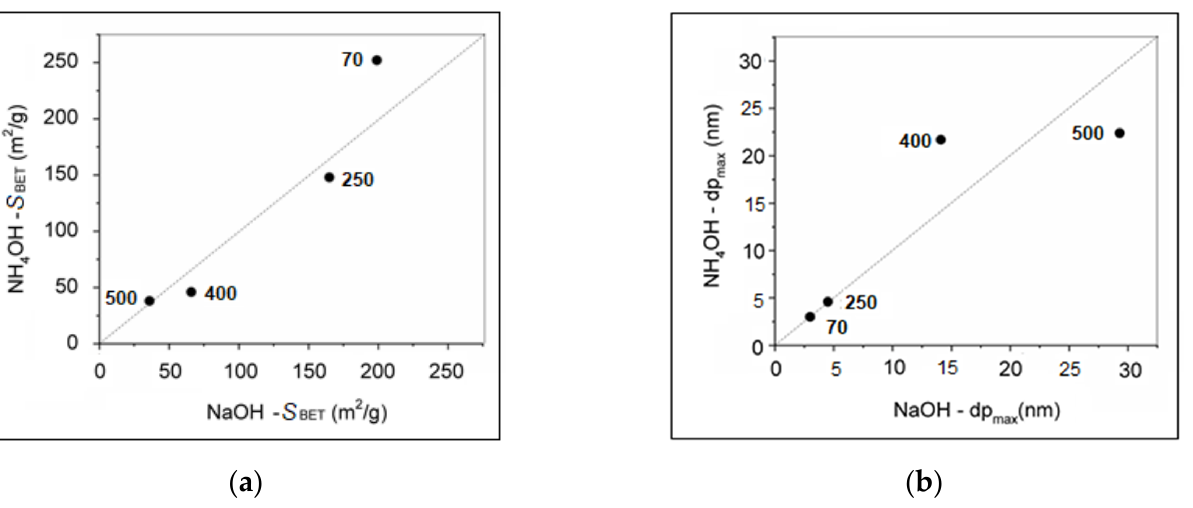
( b ) Figure 12. Hydrohematite samples after 2 h of the methane catalytic oxidation test: ( a ) XRD patterns with the peaks denoted as: H = Fe 2 O 3 and M = Fe 3 O 4 ; ( b ) The lattice parameters a, c of Fe 2 O 3 _Na ‐ 500 and Fe 2 O 3 _NH ‐ 500 catalysts were expanded in Fe 2 O 3 _Na ‐ 500 cat and Fe 2 O 3 _NH ‐ 500 cat . After the catalytic test, goethite in Fe 2 O 3 _Na ‐ 70 and protohematite in Fe 2 O 3 _NH ‐ 70 were reduced by CH 4 in Fe 2 O 3 _Na ‐ 70 cat and Fe 2 O 3 _NH ‐ 70 cat (Figure 12a) to the magnetite (PDF No. 01 ‐ 080 ‐ 7683) according to (Equation (5)). After 2 h of catalytic experiment, the highest CH 4 conversion 45.7% to CO 2 and H 2 O took place on the S BET of Fe 2 O 3 _NH ‐ 70 larger about 53 m 2 /g in comparison with Fe 2 O 3 _Na ‐ 70 (Table 1). The calcined Fe 2 O 3 _Na ‐ 500 and Fe 2 O 3 _NH ‐ 500 samples preserved hydrohematite and magnetite in Fe 2 O 3 _Na ‐ 500 cat and Fe 2 O 3 _NH ‐ 500 cat (Figure 12a). The CH 4 conversion 30.7 and 36.4% was related to the S BET 36 and 38 m 2 /g, respectively, and particles size (Table 1). The small amount of hydrogen in the gaseous products and the formation of